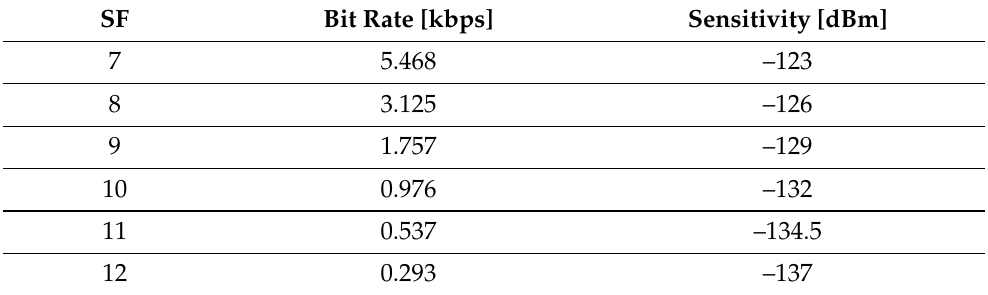
Table 1. LoRa configuration parameters for 125 kHz bandwidth.